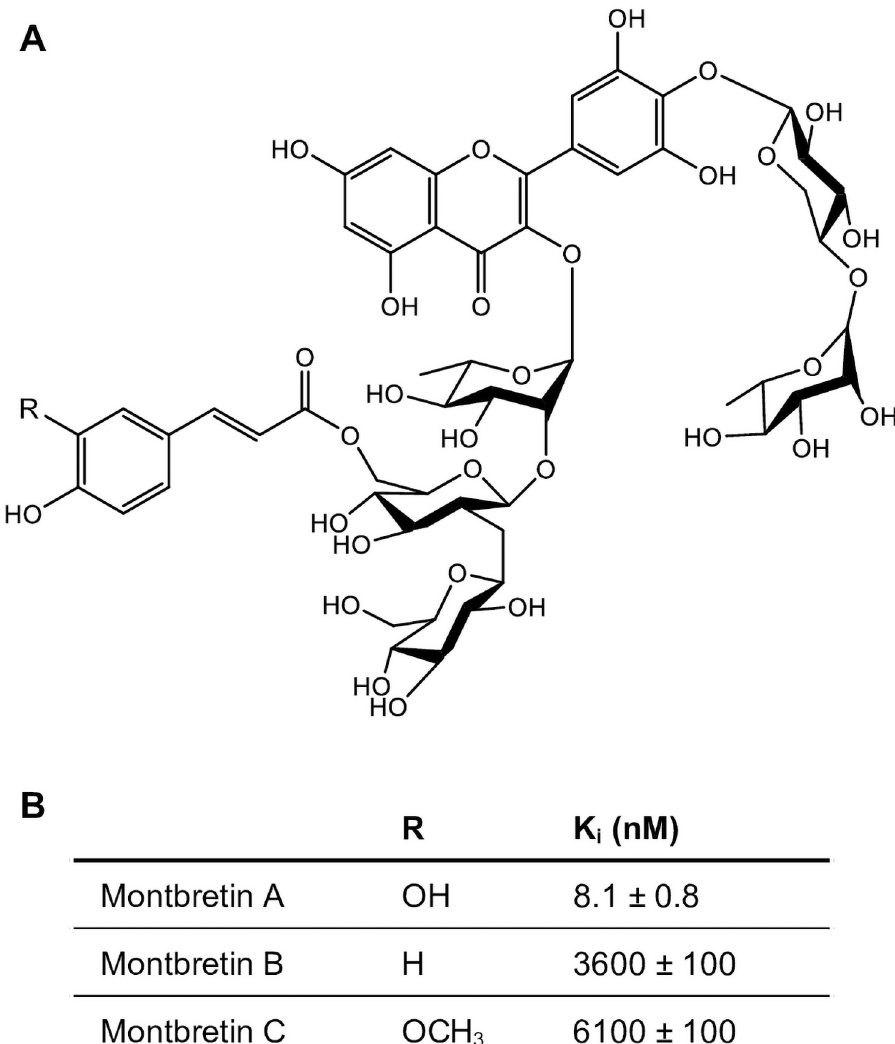
Fig 1. Structures and inhibitor activity of montbretin A, B and C found in montbretia corms. (A) Montbretin A (MbA) contains a caffeoyl moiety which contributes to the highly efficient inhibition of human pancreatic α -amylase (HPA). MbB and MbC have a coumaroyl- and feruloyl moiety, respectively, and are not effective HPA inhibitors. (B) K i values for HPA inhibition were reported previously